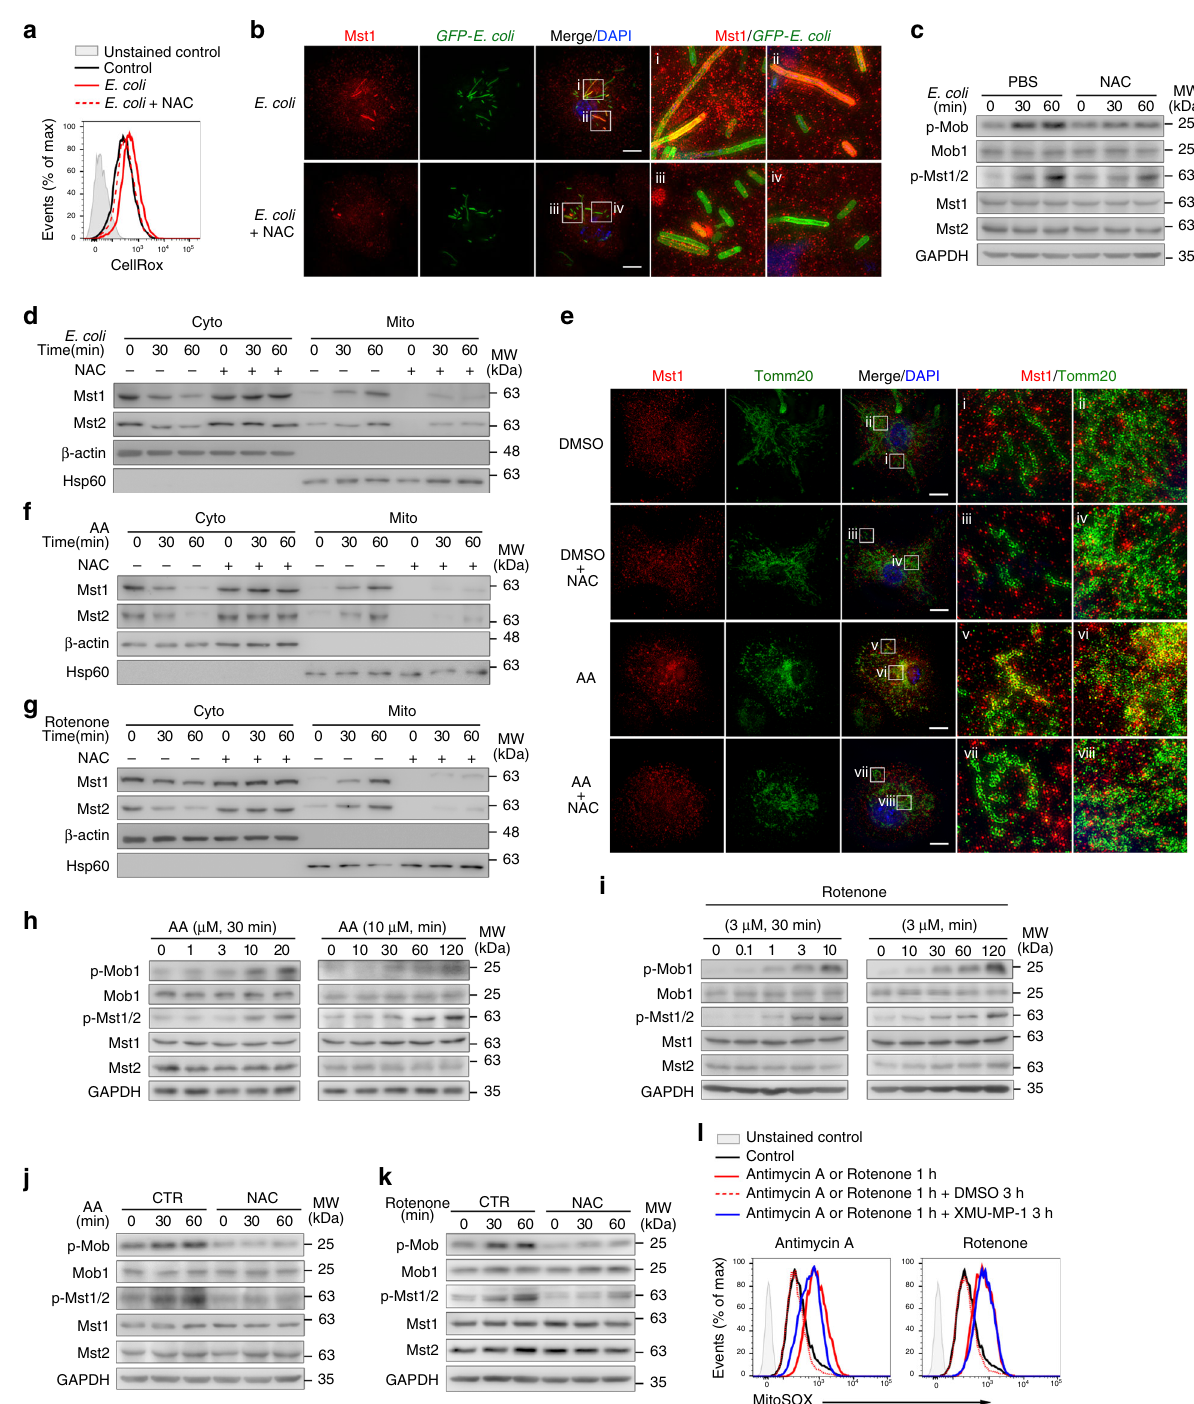
Mst1/2 sense phagosomal and mitochondrial ROS . Phagocytes primarily rely on the two main ROS sources, mitochondrial and mitochondrial compartments with super-resolution immuno- fl uorescence microscopy (SIM) approach and immunoblot, respectively (Fig. 3a – d), while treatment with NAC abolished the Mst1/2-phagosome interaction and attenuated Mst1/2 activation (Fig. 3b – d). Similarly, Mst1/2 were recruited from the cytosol